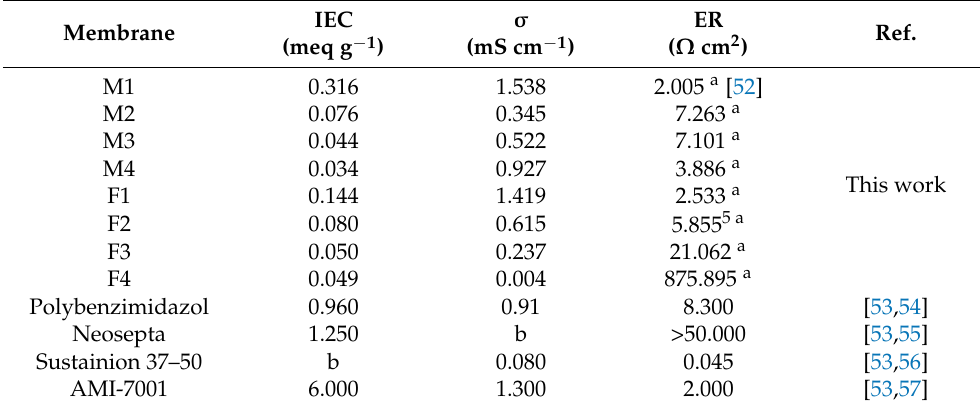
Table 3. IEC and hydroxide conductivity values for PEI/Fumion ® membranes. Membrane